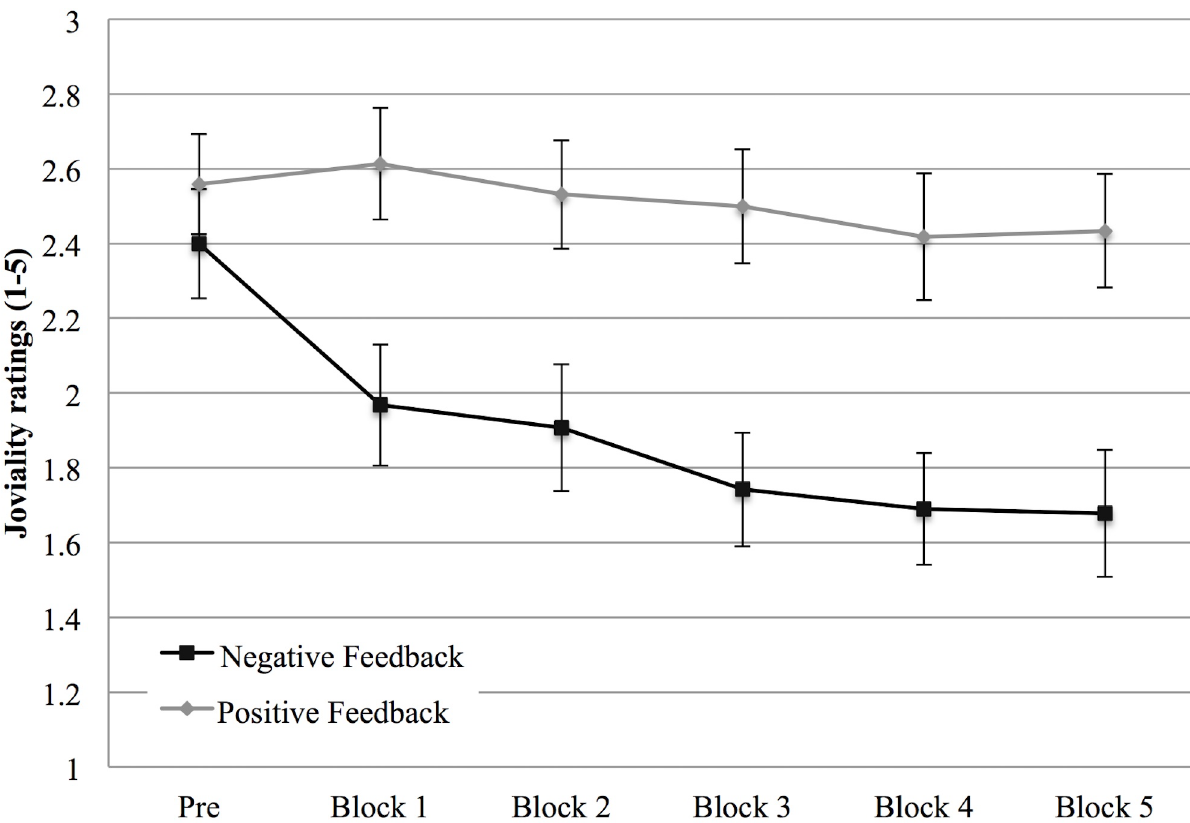
Fig 5. Joviality (Study 1). Joviality intensity at the beginning of the experiment (PRE) and after each block in the positive and negative feedback condition. Error bars indicate 1 standard error above or below the